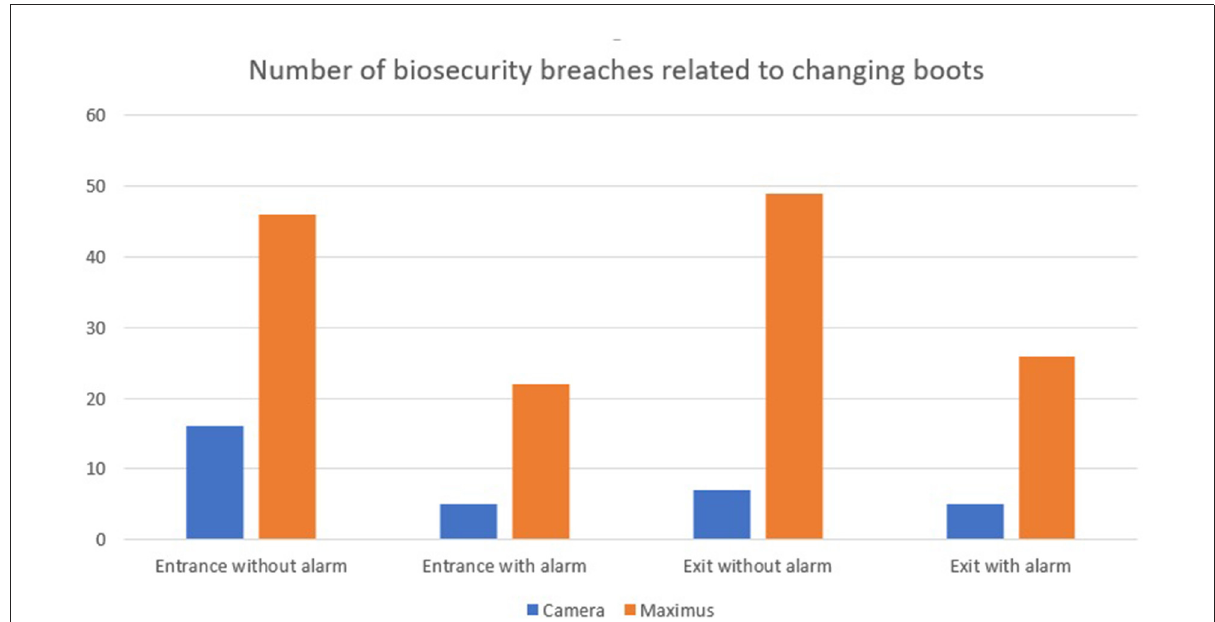
FIGURE8 Number of biosecurity breaches related to changing boots recorded by the camera vs. the Maximus system (with and without the